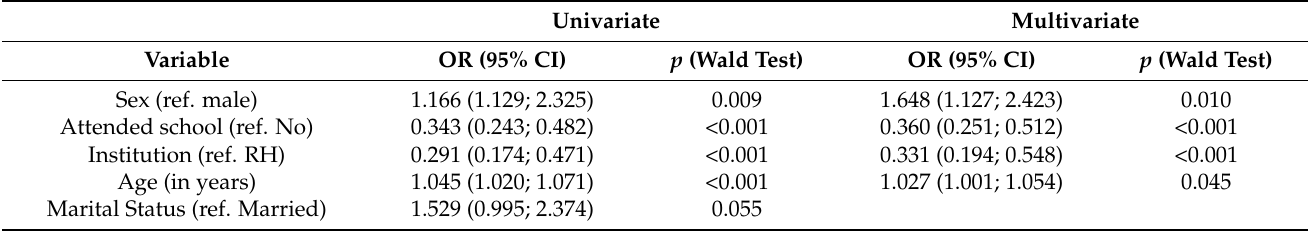
Table 4. Univariate and multivariate logistic models for moderate or severe cognitive impairment (total MMSE ≤ 18). Univariate Multivariate